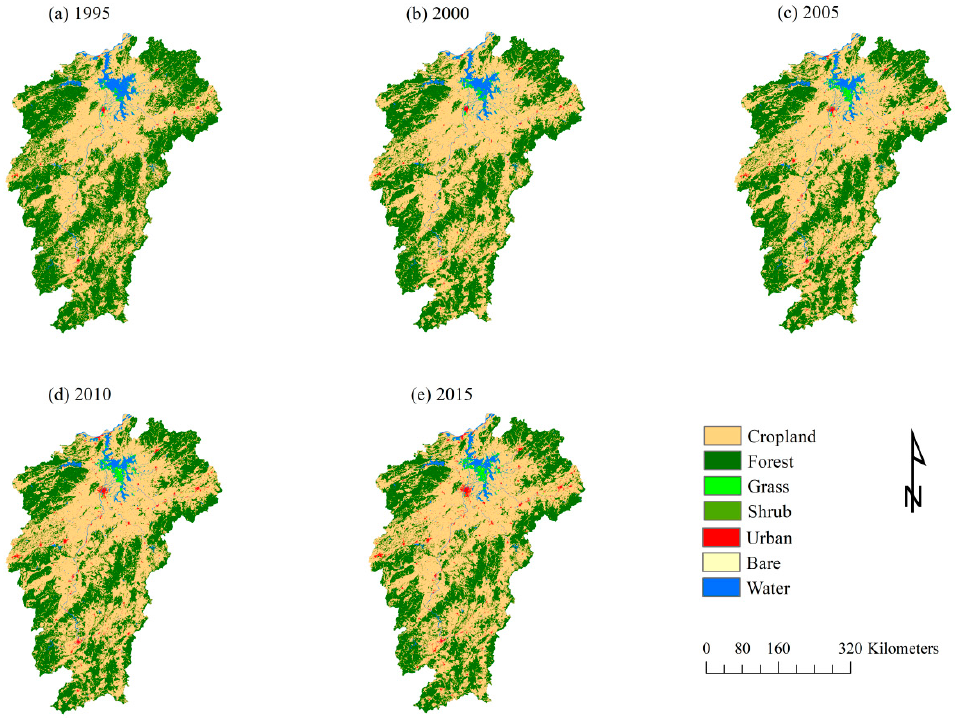
Figure 2. Land cover dynamics of Jiangxi province: ( a ) land cover in 1995; ( b ) land cover in 2000; ( c ) land cover in 2005; ( d ) land cover in 2010; and ( e ) land cover in 2015.